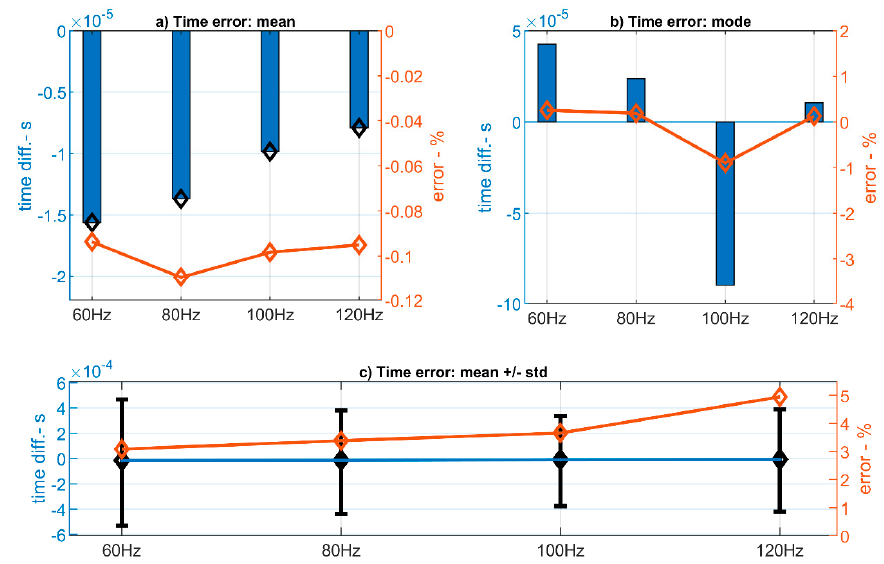
Figure 16. Estimation of time error through ( a ) the mean, ( b ) the mode, and ( c ) the addition of the mean and the standard deviation.